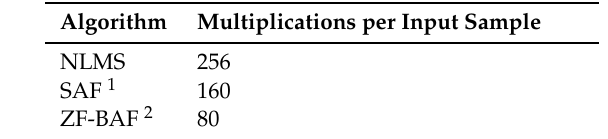
Table 3. Computational Burden in test case 1.